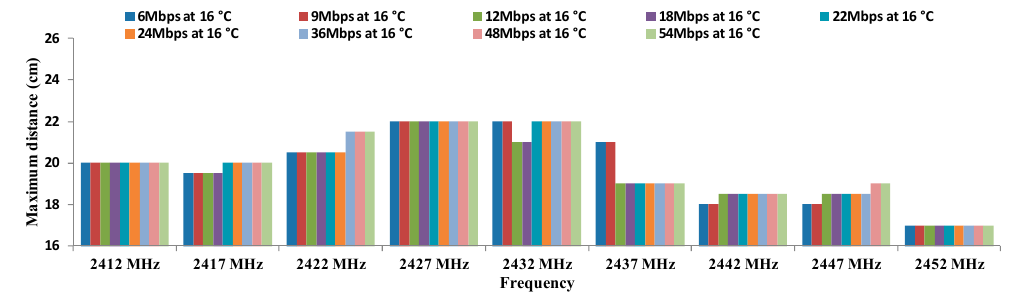
Figure 11. Maximum distances for OFDM at 16 °C.